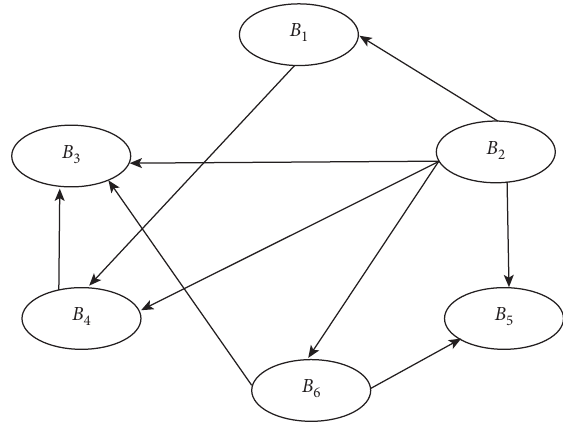
Figure 2: Outranking relation of banks.